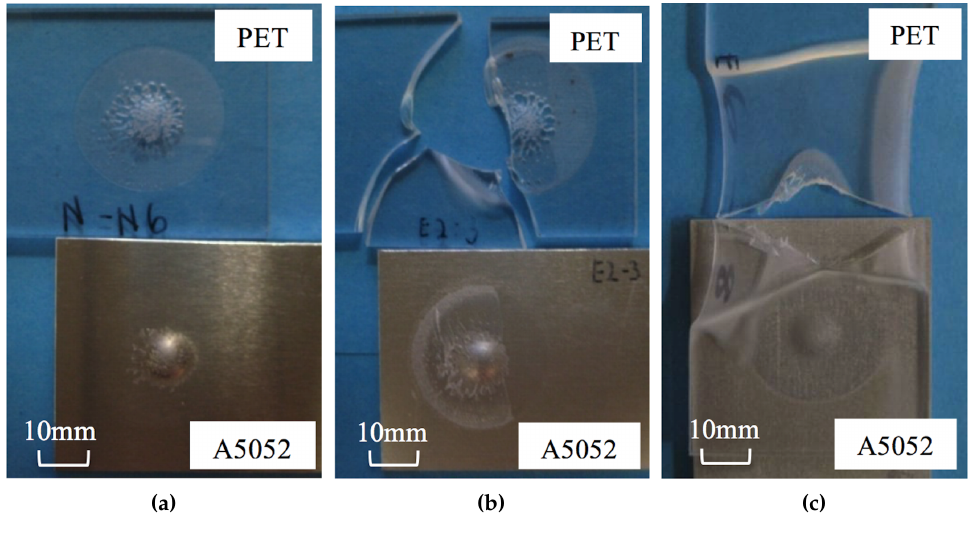
Figure 4. Three types of failure mode occurred in the A5052-PET joints. ( a ) Separation at welded interface; ( b ) fracture at the edge of bubbles or hollow structures; and ( c ) fracture at the edge of welded area after PET